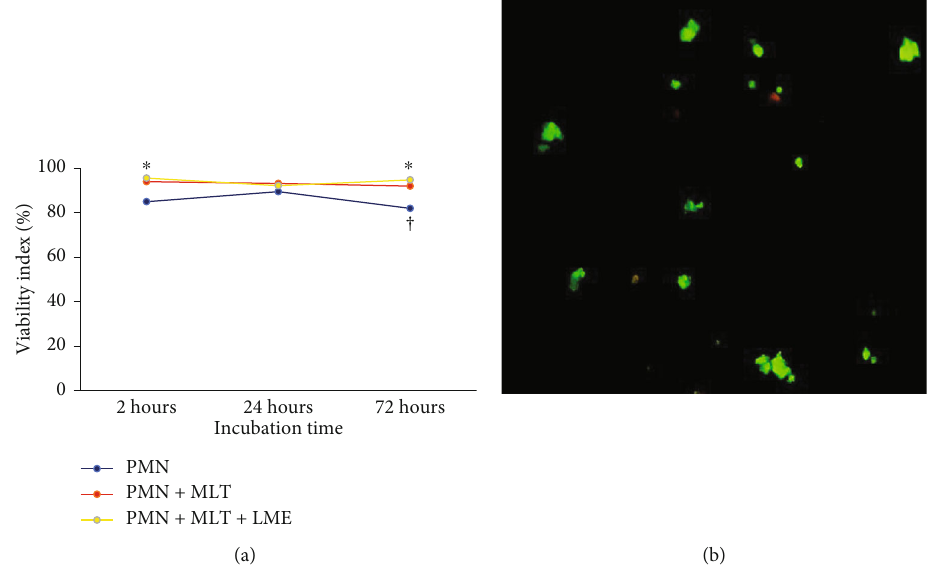
Figure 1: Time-dependent correlation of viability of PMN cells stimulated with melatonin (a). F = 9 : 26 ; p = 0 : 0018 (time of incubation), F = 14 : 4991 ; p = 0 : 0003 (treatment). The results represent the median of the standard deviation. PMN: polymorphonuclear cells; MLT: melatonin; LME: liquid microemulsion. The polymorphonuclear phagocytes were incubated with melatonin after 72 hours of incubation (a). Orange-stained cells (dead) and green-stained cells (alive). Experiments were repeated fi ve times, and the results were comparable. p < 0 : 05 . ∗ Di ff erences between PMN with treated PMN (MLT or MLT +LME), considering the same incubation times. † Di ff erences between times of incubation, considering the same